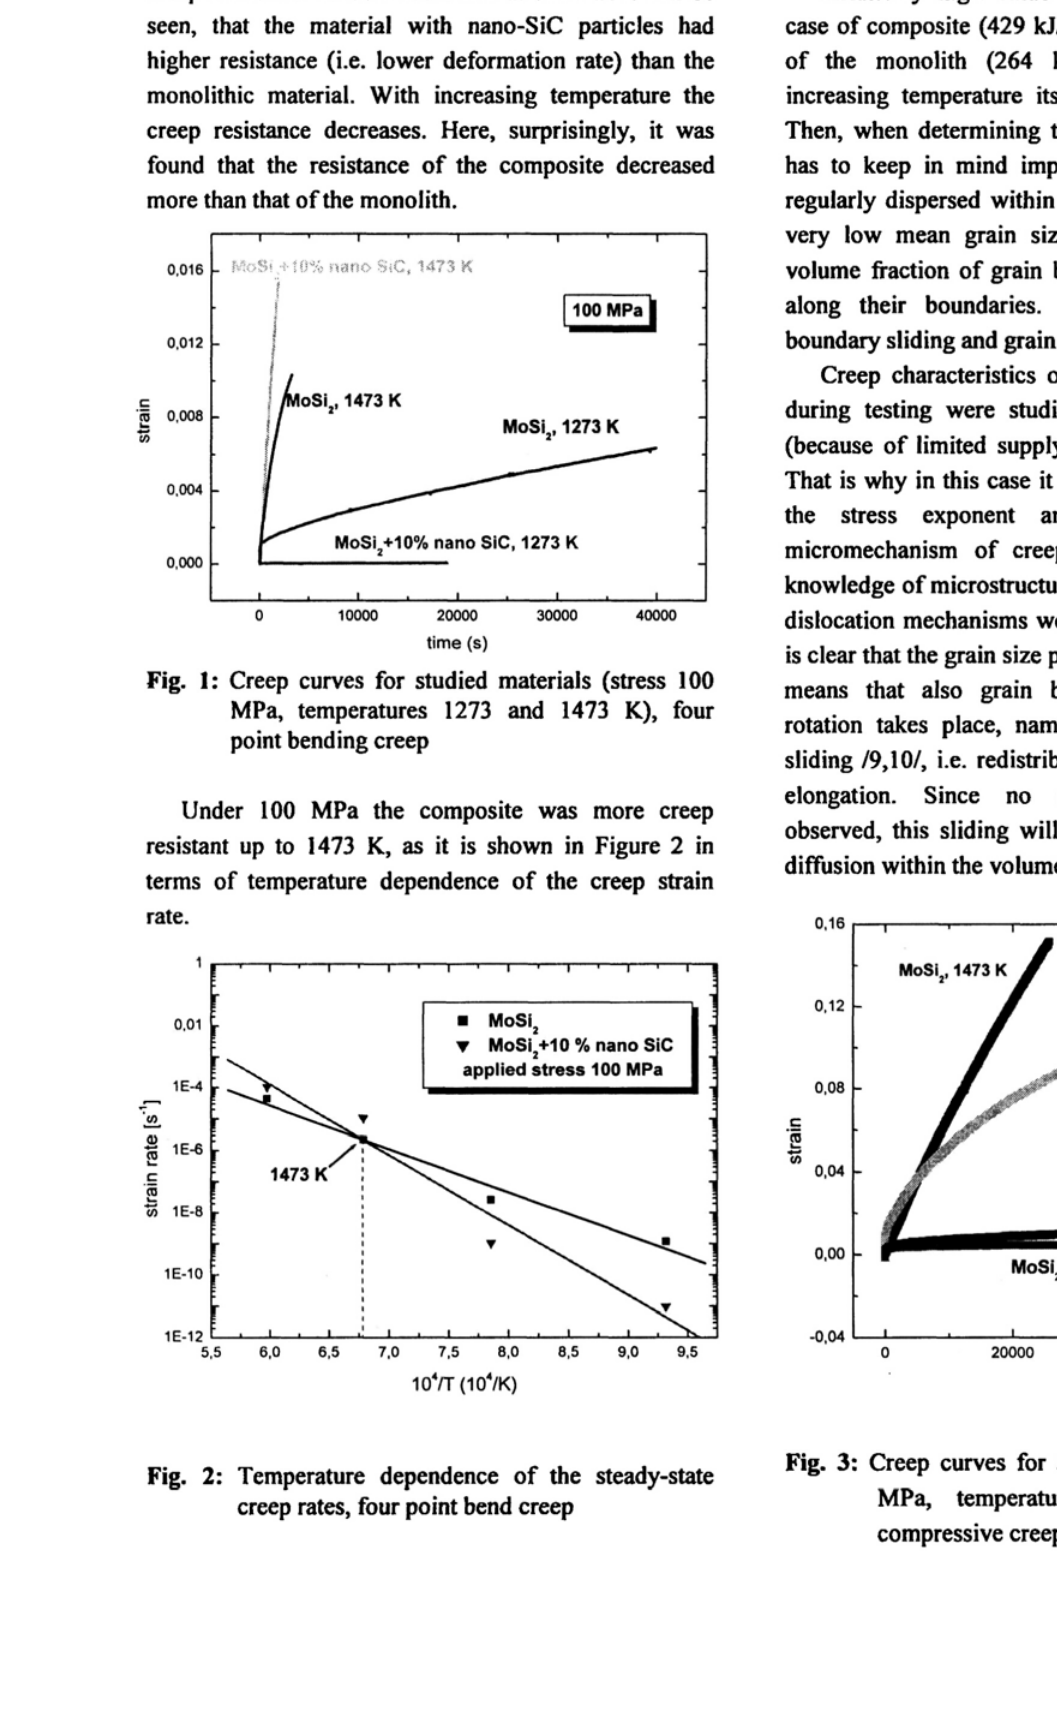
Fig. 3: Creep curves for studied materials (stress 100 MPa,